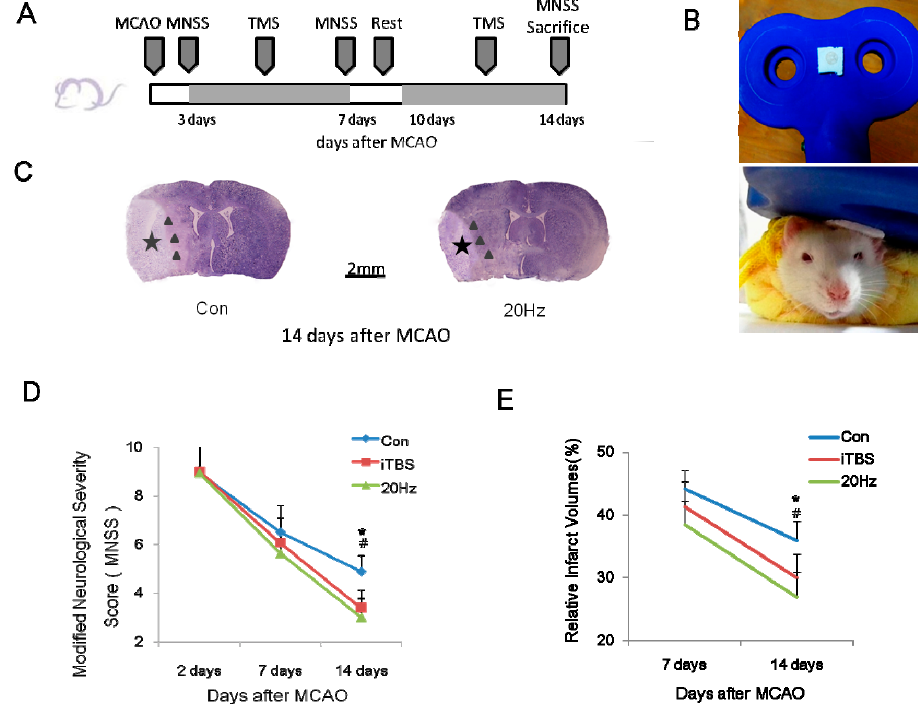
Figure 1. High-frequency repetitive transcranial magnetic stimulation (rTMS) following ischemic injury reduced the severity and volume of infarcts assessed 14 days later. ( A ) Experimental schedule; ( B ) Stimulation coil and method; ( C ) Representative examples of Nissl staining of brain tissues at 14 days after transient middle cerebral artery occlusion (MCAO). The location of the infarct area was indicated by a black star, and the peri-infarct striatum was indicated with black triangles; ( D , E ) Modified Neurological Severity Score (MNSS) values and infarct area volumes were reduced at 14 days, but not seven days, after MCAO in the intermittent theta burst stimulation (iTBS) and 20 Hz groups compared to controls. Values are mean ± SD; * p < 0.05 versus 20 Hz group; # p < 0.05 versus iTBS group. The scale bar in ( C ) applies to both slices shown in ( C ).